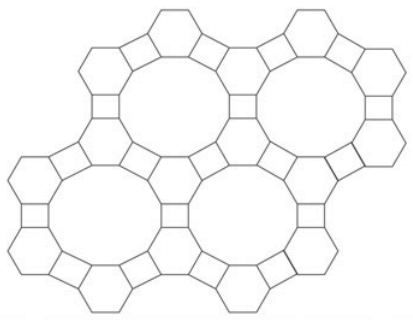
Figure 1. The AFI